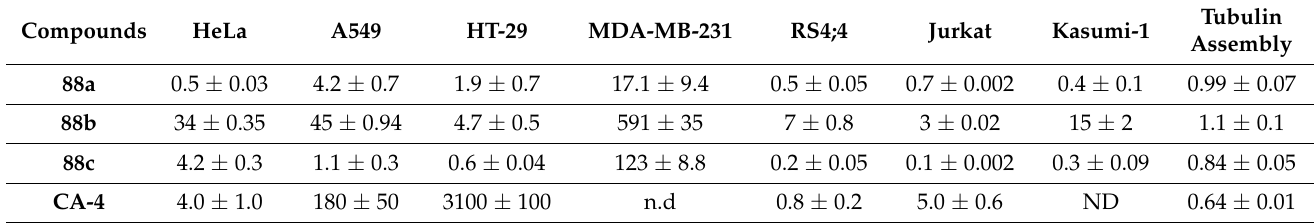
Figure 26. Chemical structures of quinolinone hybrids evaluated against a panel of cancer cell lines. Table 6. In vitro cell growth inhibitory effects of compounds GI 50 (nM) and inhibition of tubulin assembly IC 50 (nM). Compounds